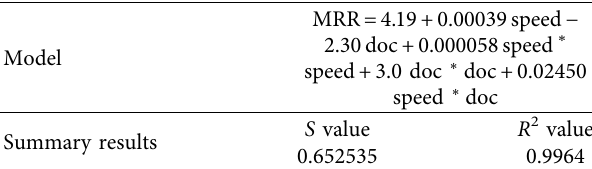
Table 8: Regression model and summary results for